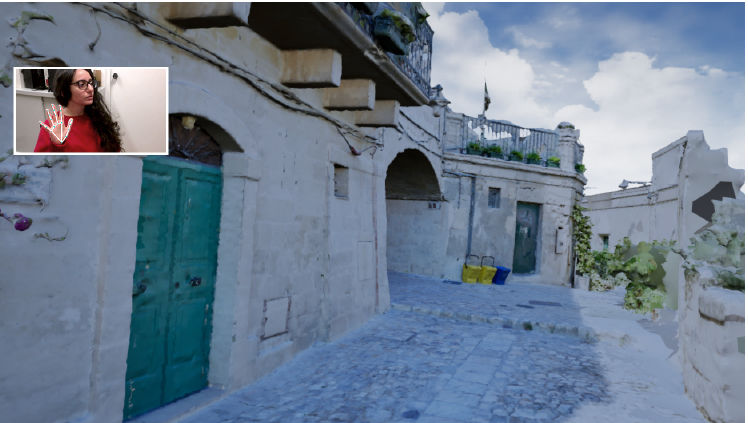
Figure 11. A view of the virtual walkthrough application during